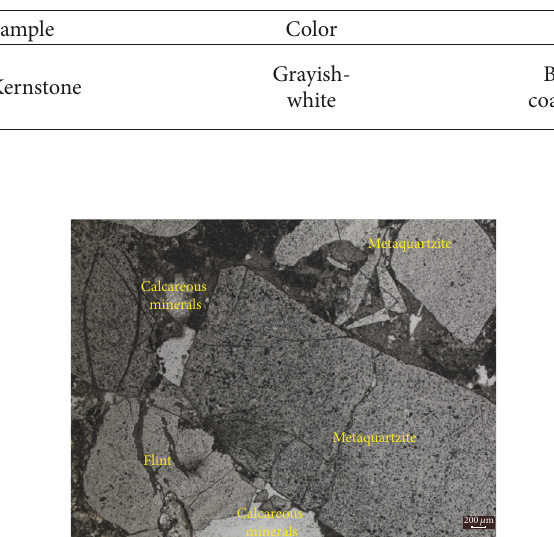
Table 1: Analysis results of the mesostructure.